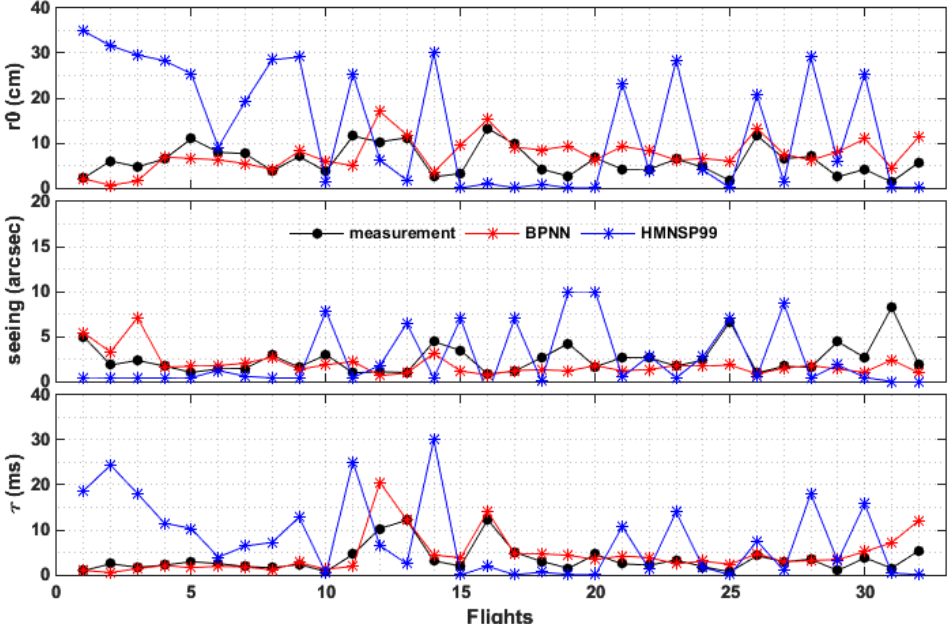
Figure 7. Comparison of integrated astroclimatic parameters between measurement, the BPNN approach and the HMNSP99 model.